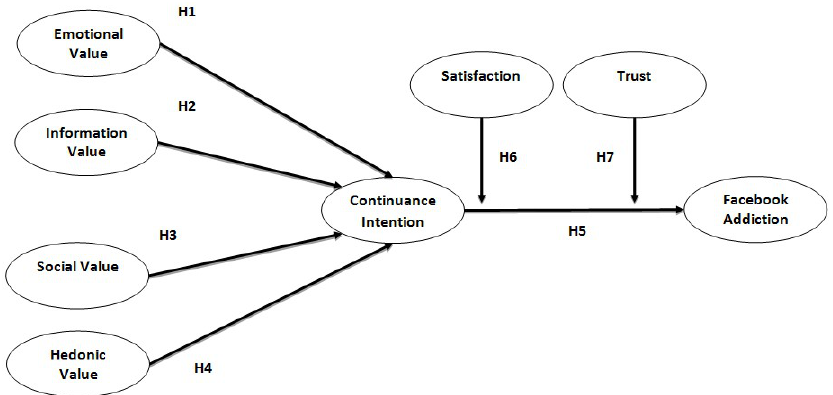
Figure 1. Research model.